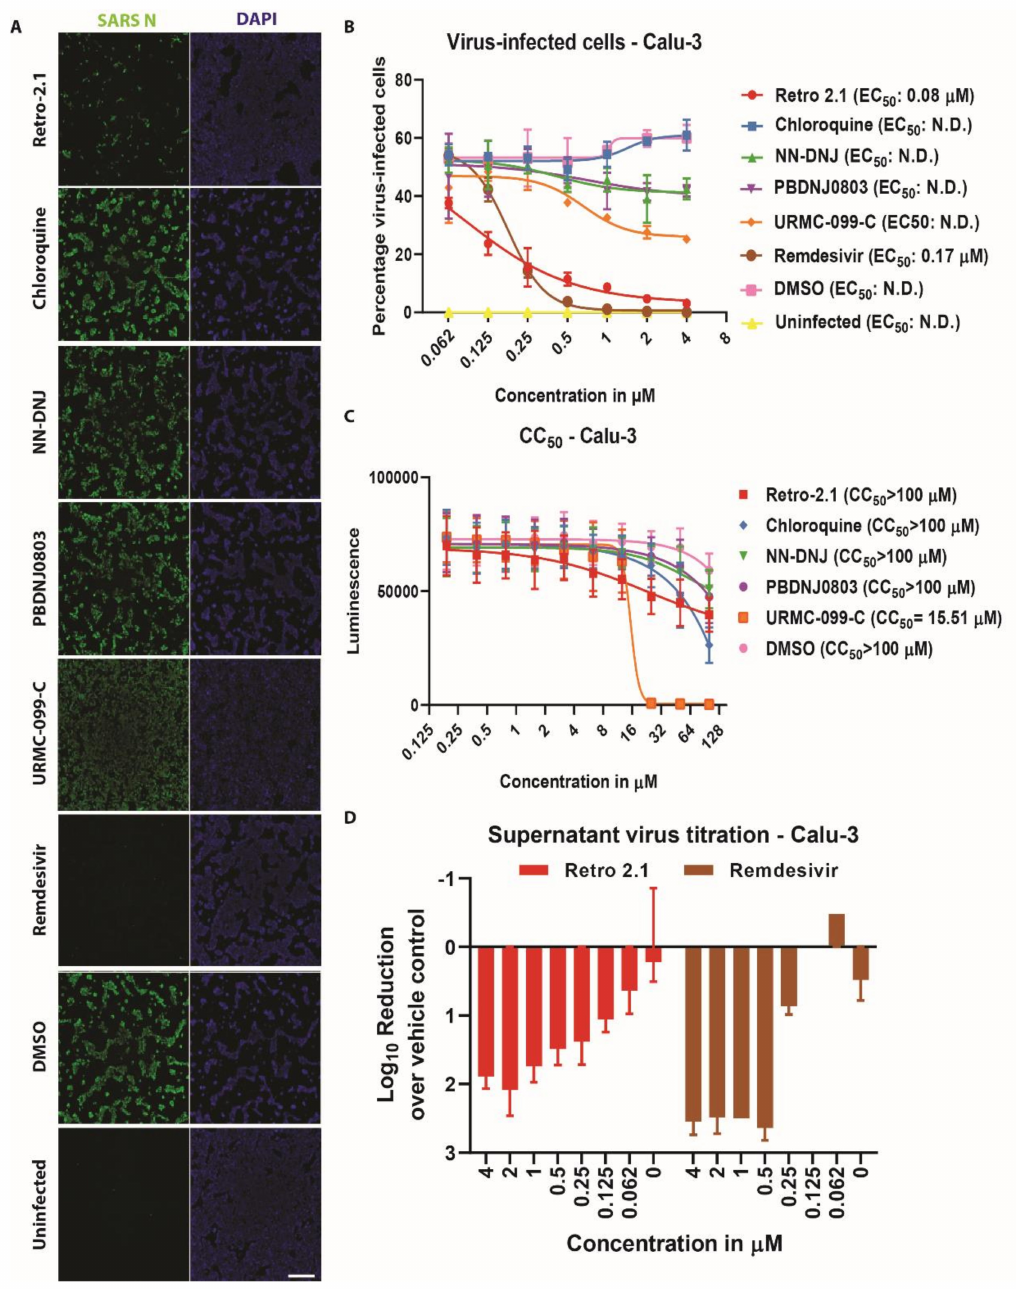
Figure 4. Analysis of the antiviral e ffi ciency on Calu-3 cells. Calu-3 cells were pre-treated 2 h at the indicated concentration prior to SARS-CoV-2 infection (MOI 0.02) at 37 ◦ C in a humidified incubator with 5% CO 2 . Cells were fixed 48 h post-infection, followed by immunostaining with the cross-reactive SARS-CoV nucleoprotein antibody (SARS N) and DAPI ( A ). The images are representative of the results of three individual experiments (only treatments with 4 µ M are shown). Scale bar: 1000 µ m. The half maximum inhibitory concentration (EC 50 ) was determined using the percentage of infected cells and half maximum cytotoxicity concentration (CC 50 ) was determined using cell viability ( B , C ). Results are displayed as means and SD of three individual experiments. Abbreviation: N.D.: not determined. Corresponding log 10 -reduction in SARS-CoV-2 viral titer for Retro 2.1 and remdesivir treatments ( D